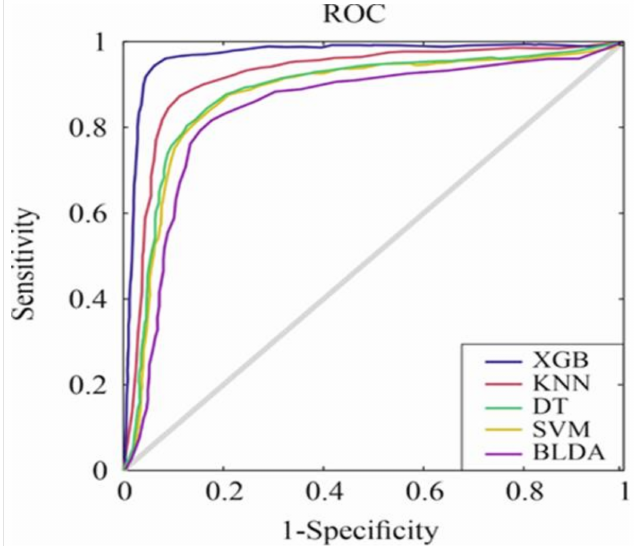
Figure 2. ROC curves for the five assessed machine learning predictors. Abbreviations: ROC: